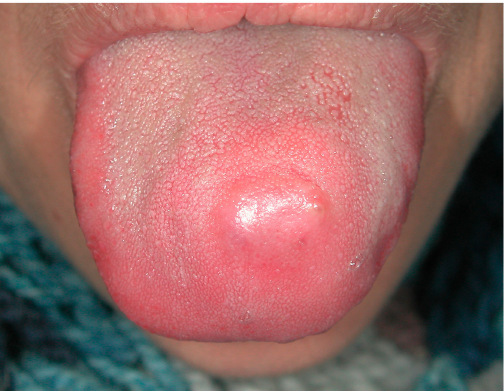
Figure 1. Tongue swelling with pus discharge diagnosed as actimomycosis by a fine needle/core needle